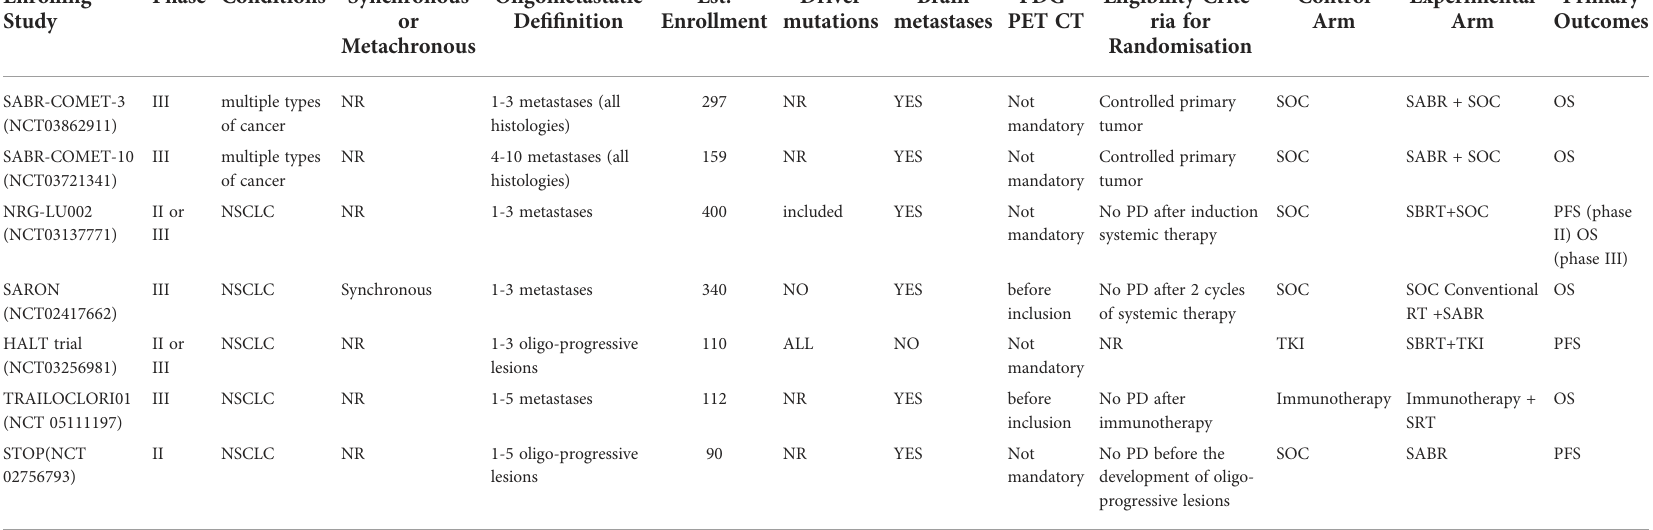
TABLE 1 Ongoing randomized